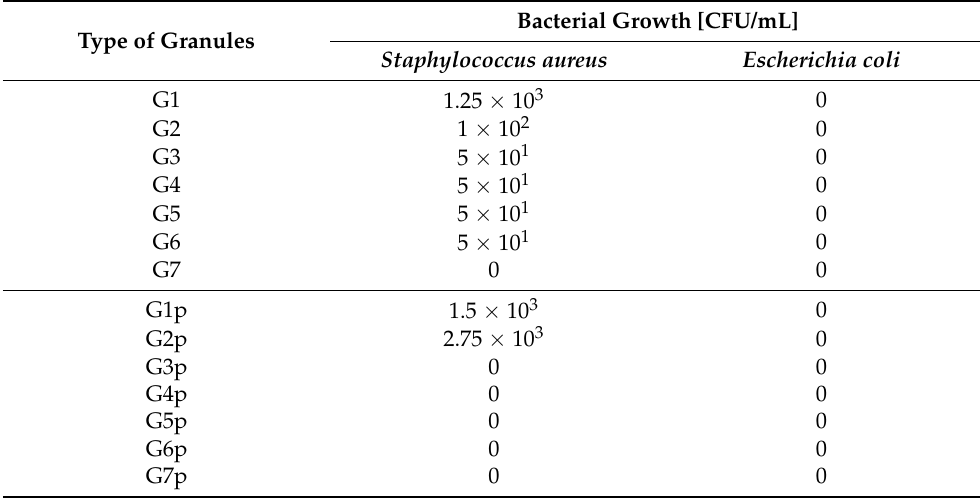
Table 5. Bacterial growth of S. aureus and E. coli in medium containing examined samples after 24 h of incubation.